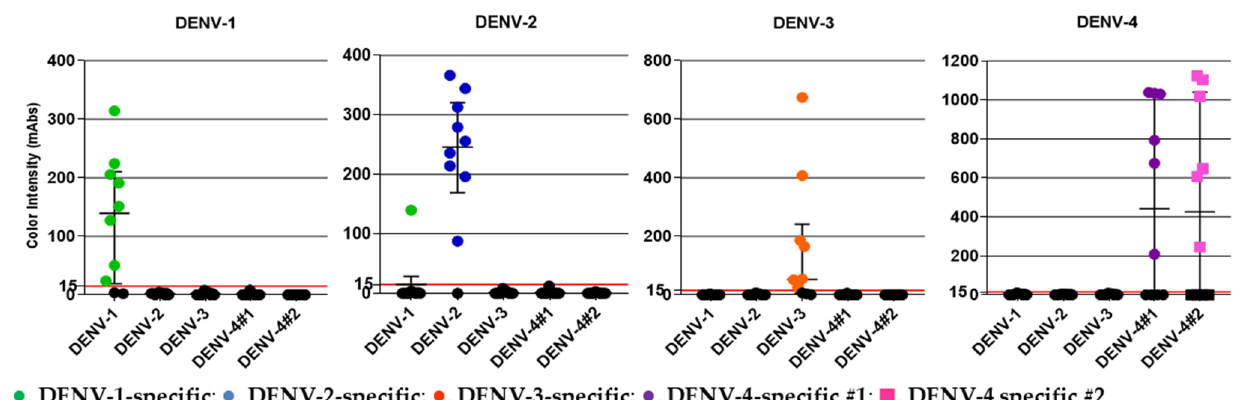
Figure 4. DENV patient serum samples from the Hospital for Tropical Diseases, Bangkok, Thailand, collected during 2018–2020, were used in the study. DENV serotype of the specimen is shown at the top of each panel. The y-axis indicates color intensity quantified as milli-absorbance (mAbs) units using an immunochromatogram reader. Results obtained from five serotype-specific devices are shown. The green ( ● ), blue ( ● ), orange ( ● ), and purple ( ● ) circles and pink ( ) squares represent positive serum samples detected using the DENV-1, -2, -3, -4 #1, and -4 #2 devices, respectively. Median and interquartile ranges of color intensity (mAbs) are shown. The grid line at 15 mAbs on the y-axis was set as the cut-off value of the devices. Each of the data points represents the result of a single device.